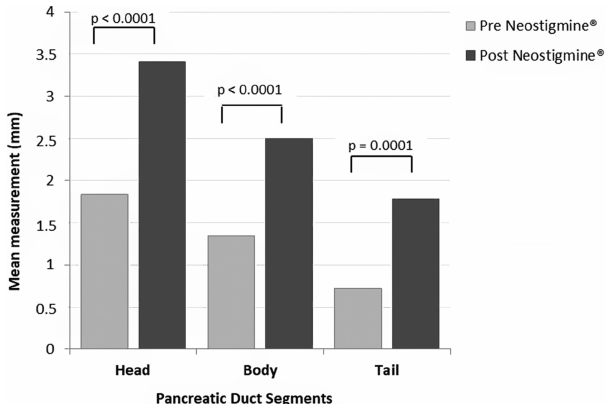
Figure 1. The bar graph shows the mean diameter of the main pancreatic duct in the head, body, and tail before and after 40 minutes of Neostigmine ® administration. Grey bars: before Neostigmine ® , Black bars: after Neostigmine ® .